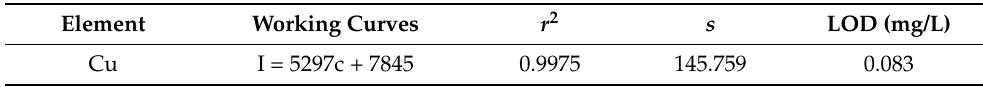
Figure 11. Working curve for Cu. Table 1. Analytical performance of APNDP for detecting the Cu element.